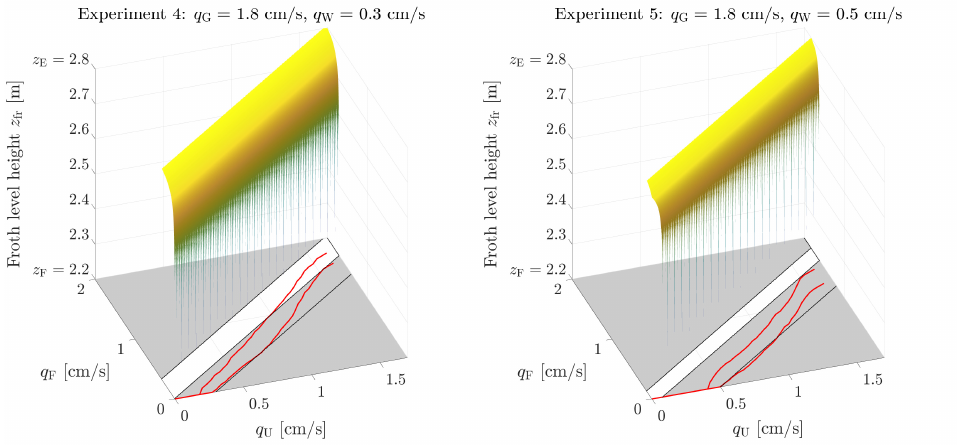
Figure 10. Experiments 4 and 5 (with wash water added): comparisons between the model and experiments with stationary